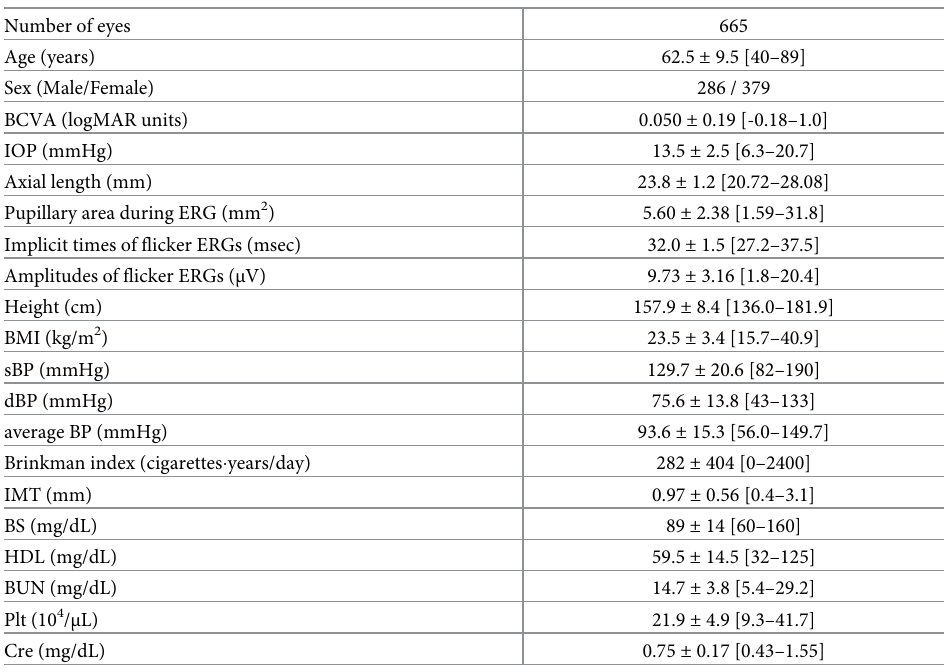
Table 1. Demographic